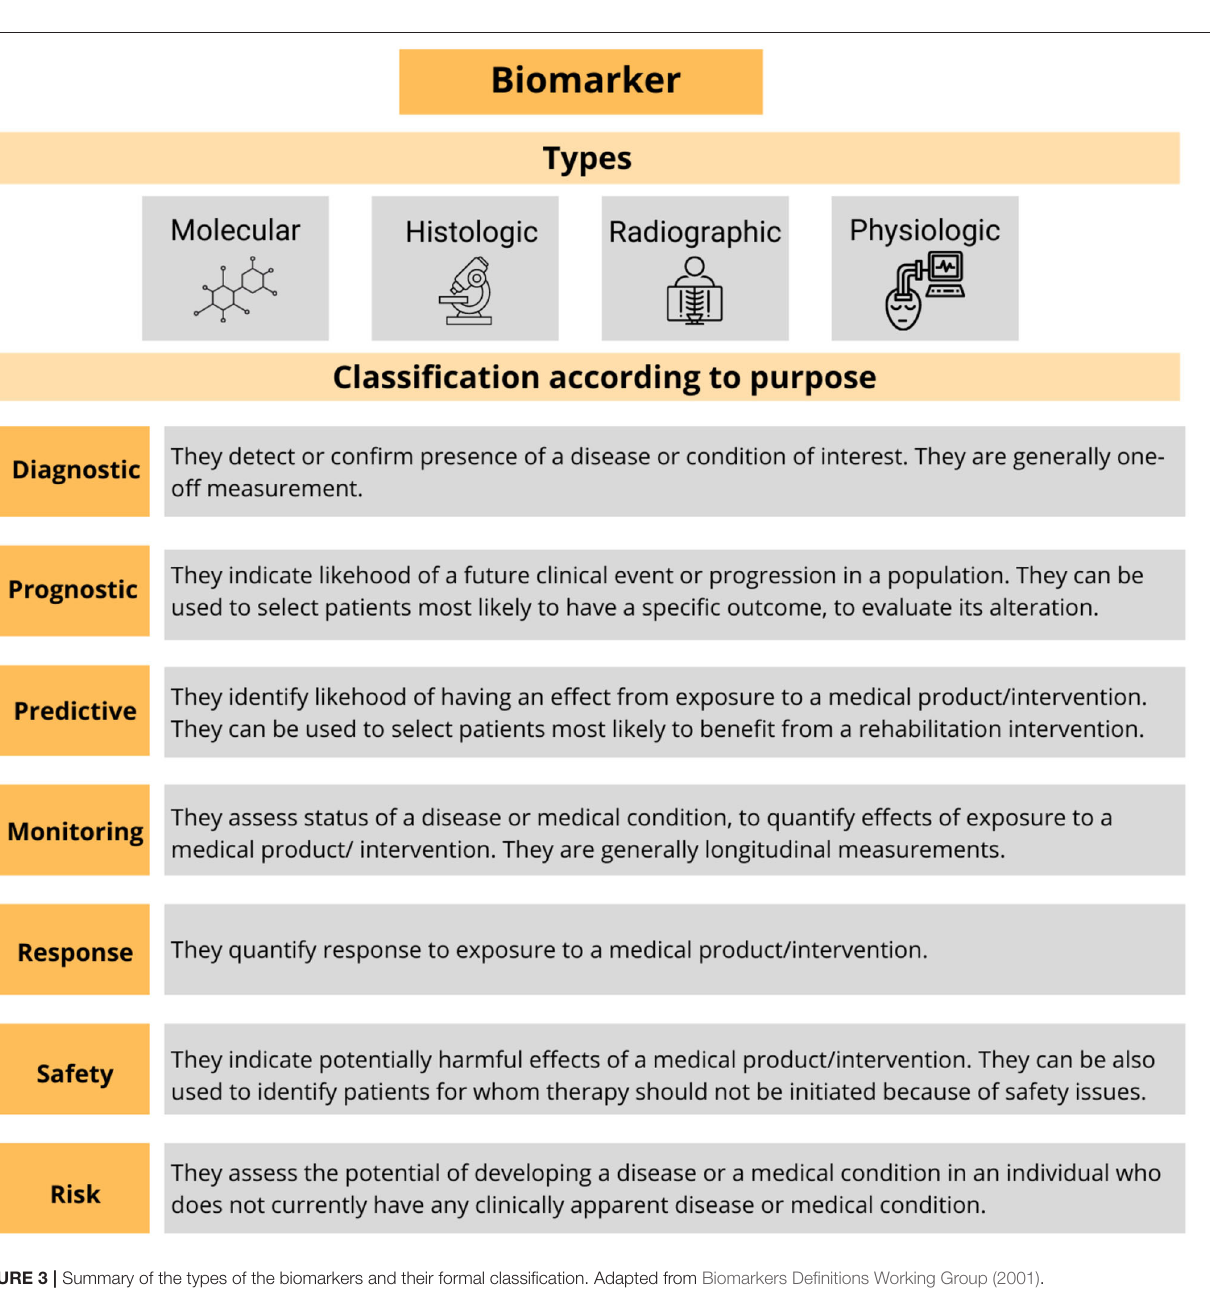
FIGURE 3 | Summary of the types of the biomarkers and their formal classification. Adapted from Biomarkers Definitions Working Group